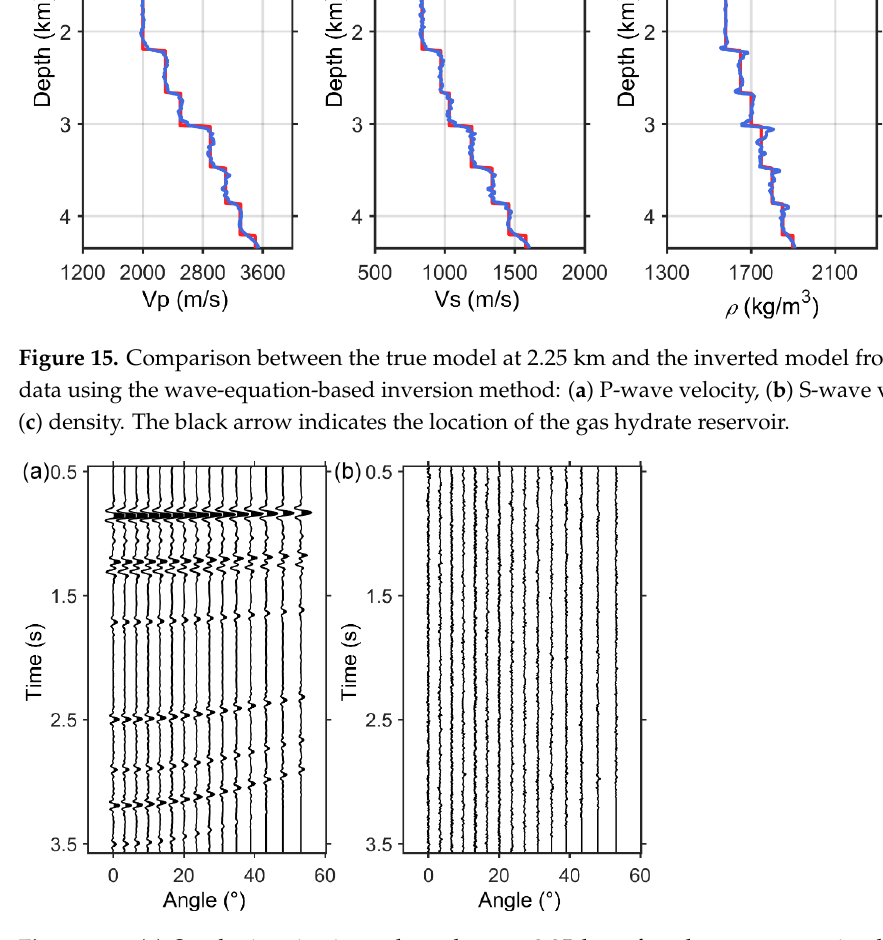
Figure 16. ( a ) Synthetic seismic angle gathers at 2.25 km after the wave-equation-based inversion method, ( b ) difference between the real seismic gather in Figure 10b and synthetic seismic gather in ( a ).